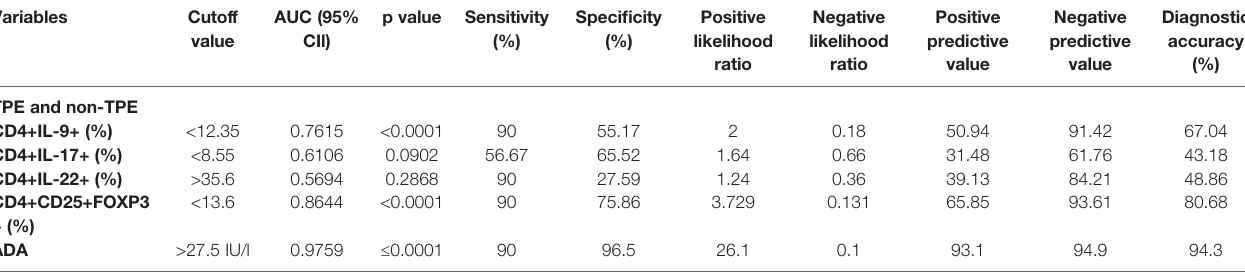
TABLE 4 | The diagnostic accuracy of CD4+IL-9+, CD4+IL-17+, CD4+IL-22+, CD4+CD25+FOXP3+ T cells, and ADA in the differentiation of tuberculous from non- tuberculous effusions (malignant, empyema, and parapneumonic effusions).